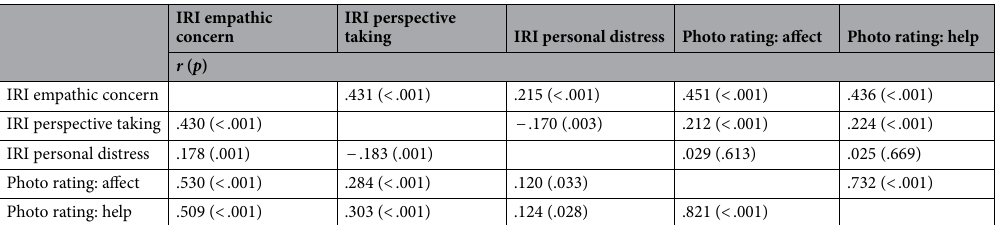
Table 2. Correlations between measures of trait empathy and state empathy separated by conditions. IRI interpersonal reactivity index. Correlations above the diagonal: in-group condition; correlations beneath the diagonal: out-group condition.